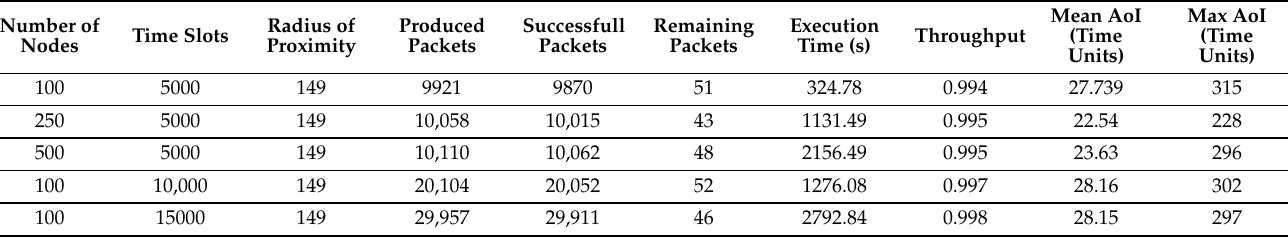
Table 11. Larger scale simulation for FRESH-neigh.